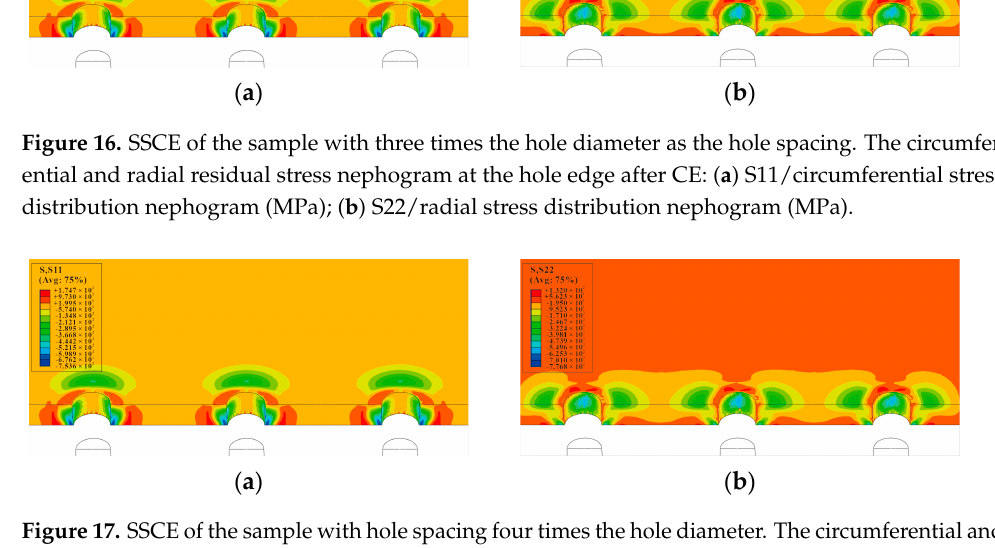
( b ) Figure 18. Residual Stress Distribution on the minimum section with the central hole of the single- hole specimen: ( a ) S11/circumferential residual stress distribution; ( b ) S22/Radial residual stress.